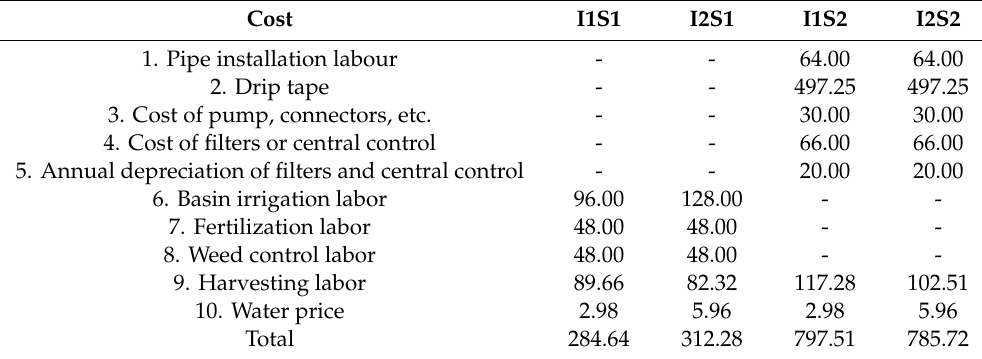
Table 7. Calculation of total cost for each treatment per ha ($ US dollars).